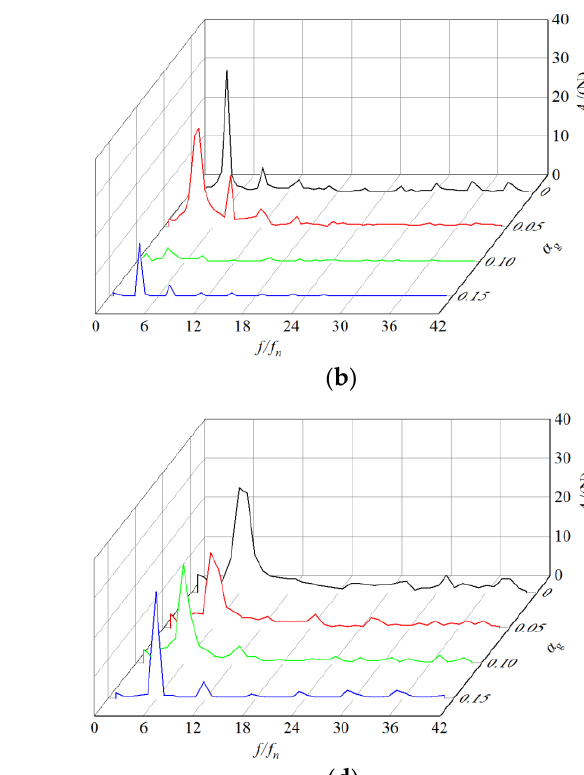
( d ) Figure 12. Time domain characteristic of radial force during the start-up process. ( a ) t = 1 s; ( b ) t = 2 s; ( c ) t = 3 s; ( d ) t = 4 s. The frequency domain diagram of radial force is obtained by the Fast Fourier trans- form (FFT) for the time domain diagram of radial force in Figure 12, as shown in Figure 13. In the graph, the abscissa represents the multiple between the radial force frequency ( f ) and the impeller rotation frequency ( f n ), and the ordinate represents the amplitude of radial force pulsation ( A r ). At t = 1 s, the dominant frequency of radial force is 2 f n , and its amplitude under gas – liquid two-phase conditions is more significant than that under pure water conditions. At t = 2 s, the dominant frequency of radial force is 4 f n . At t = 3 s, the dominant frequency of radial force is 5 f n . Its amplitude is the largest under the pure water conditions and the smallest under the condition of α g = 0.10. At t = 4 s, the dominant frequency of radial force is 6 f n , that is, the blade rotation frequency and the secondary frequency is two times the blade rotation frequency. With the increase in IGVF, the dom- inant frequency amplitude of radial force increases slightly. From the pure liquid condi- tions to the gas – liquid two-phase conditions with increasing IGVF, at the same time, the dominant frequency amplitude shows a similar trend of decreasing firstly but then in- creasing. This is because a small number of bubbles will increase the non-uniformity of the flow rate, which prompts the mainstream direction to change, and causes the radial